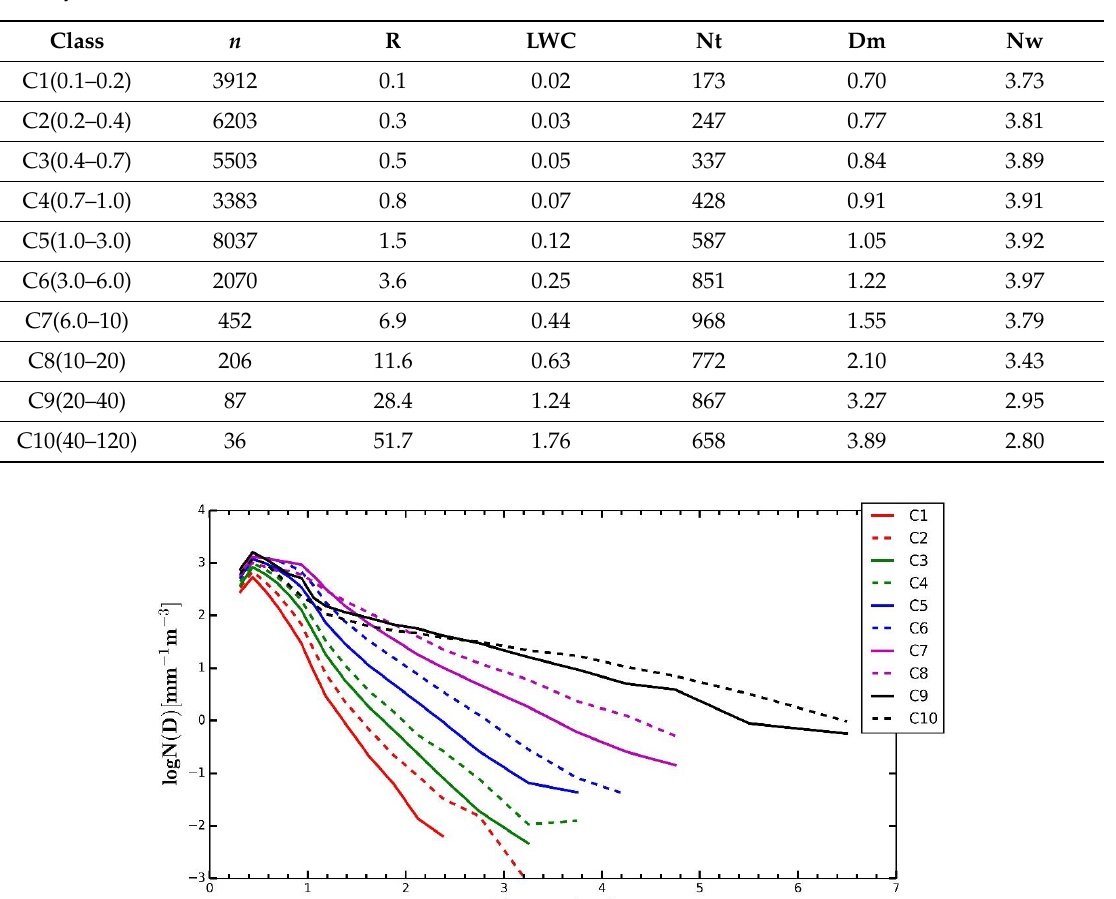
Table 1. Characteristics of the raindrops size distribution (RSD) in function of the rain rate class; number of cases ( n ) in each minute, rain rate (R [mm / h]), liquid water content (LWC[g / m3]), concentration total number (Nt [1 / m 3 ]), mass-weighted mean diameter (Dm [mm]), intercept parameter (Nw [1 / (mm